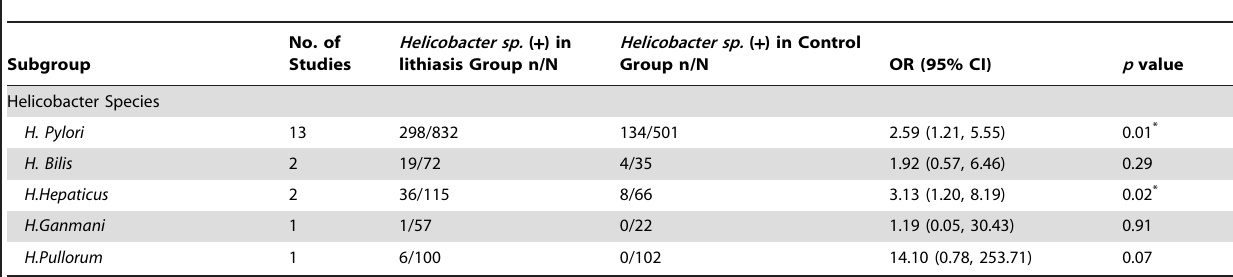
Table 2. Meta-analysis on the prevalence of Helicobacter species in cholelithiasis group compared with control group.